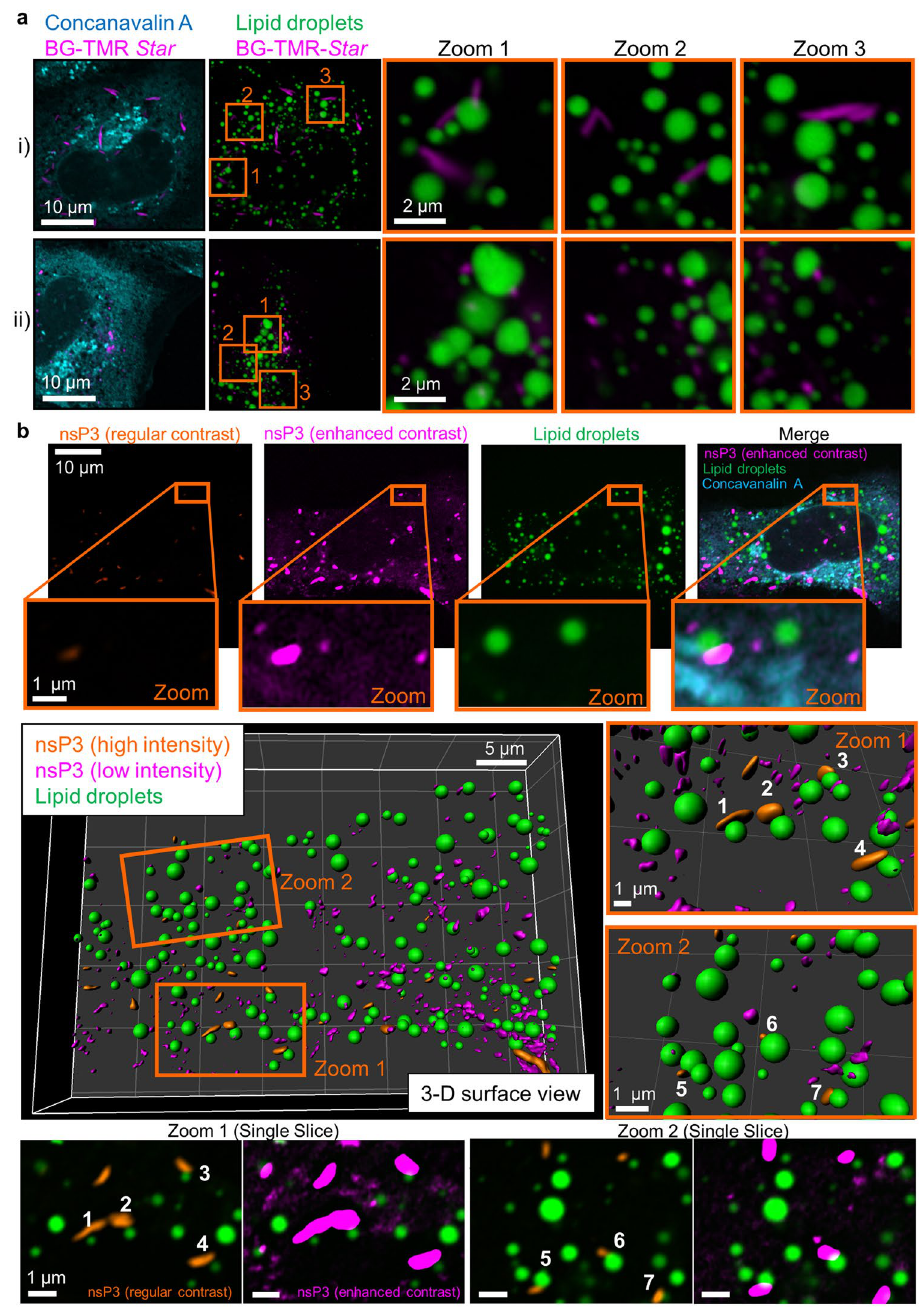
Figure 7. NsP3-positive structures are close to the surface of lipid droplets in hepatic cells. Monodansylpentane (MDH), which has a fluorescence emission between 420 and 480 nm when incorporated in lipid droplets, was used to stain lipid droplets (green). MDH was combined with the SNAP-specific red fluorescence of BG-TMR Star (magenta) and the cellular counterstain Concanavalin A conjugated to Alexa Fluor 647 dye (cyan), which selectively binds to α -mannopyranosyl and α -glucopyranosyl residues on cell membranes, such as ER and Golgi complex. ( a ) Cells with a predominance of rod-like structures (i) or granular structures (ii) were imaged with a Zeiss LSM 880 confocal system with Airyscan, operated in the super-resolution mode. Images show individual slices, which were extracted from the Z-stack of staining. Merged images of the BG-TMR- Star channel (pseudo- coloured in pink) and either Concanavalin A (cyan) or lipid droplets (green) are shown. Zoomed-in views are in the panels on the right (Zoom 1–3). ( b ) A single slice shows a region of interest from the sample prepared in ( a ). To illustrate the presence of low-intensity nsP3 clusters, we digitally enhanced the contrast of the nsP3- specific signal in one image (“enhanced contrast”). 3-D surfaces were generated from the 3-D reconstruction of Z-stacks, which consisted of 38 slices over an axial distance of 5.9 µ m. Both surface rendering and volume rendering mode were chosen for zoom-ins of two intracellular regions (Zoom 1 and 2). SNAP-nsP3 rod-like structures (1–4) and granular structures (5–7) were located close to lipid